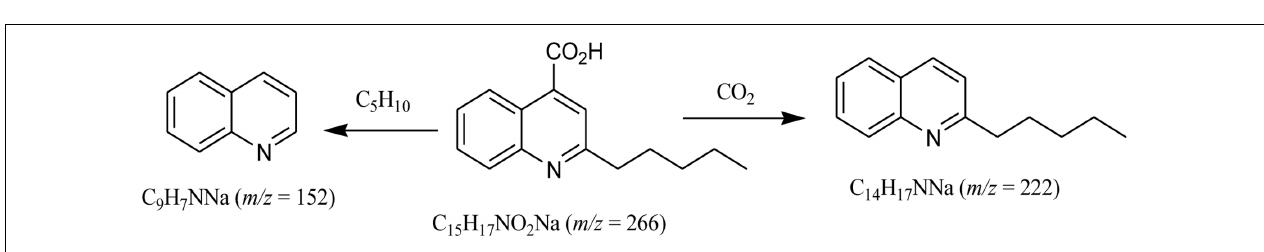
FIGURE 4 | Key mass fragmentation pattern for compound